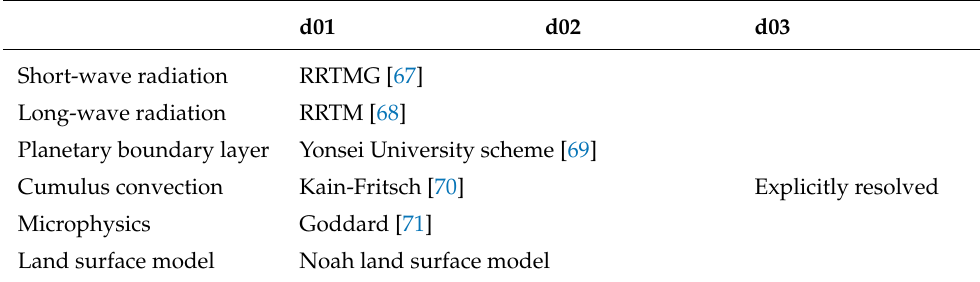
Table 1. The WRF model physics options used in this study.